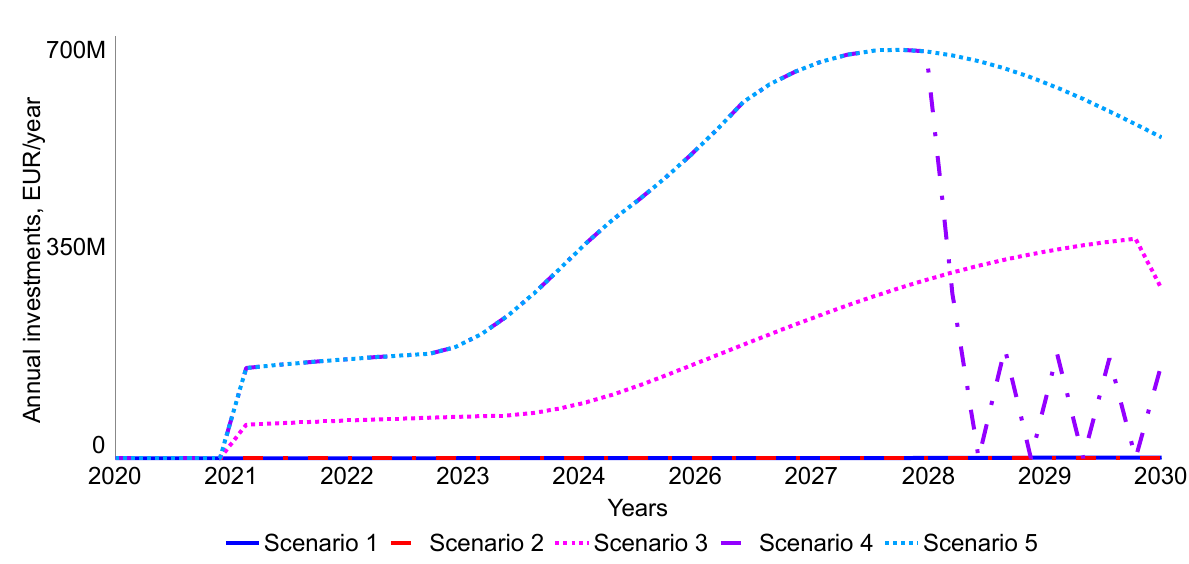
Figure 24. Simulation results of cumulative energy savings for all four scenarios.